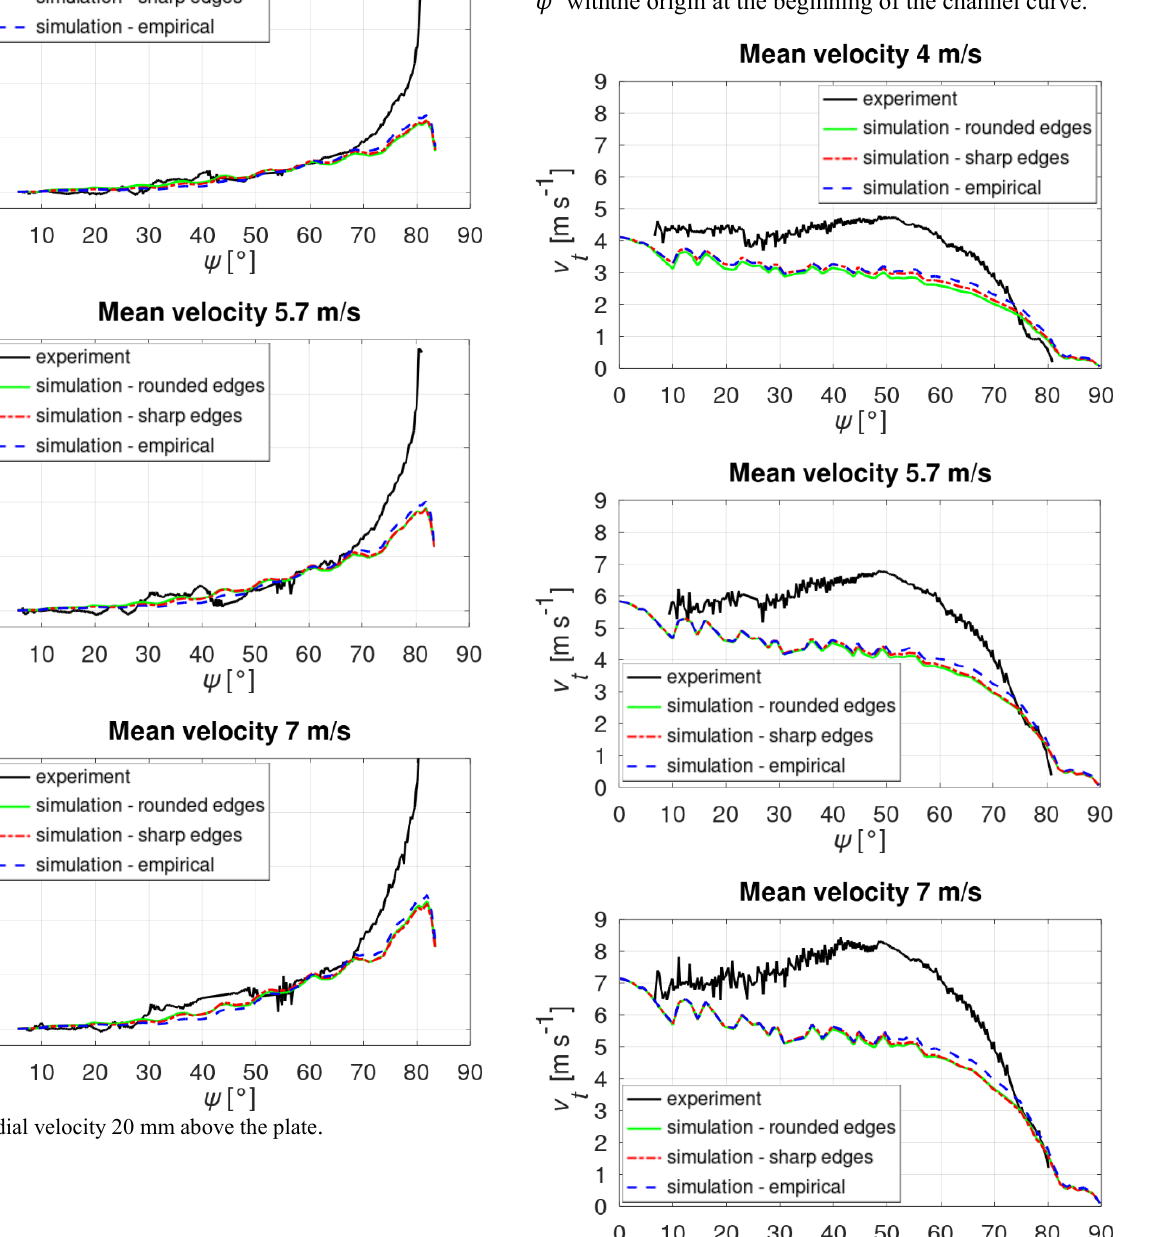
Fig. Tangential velocity 15 mm below the plate .